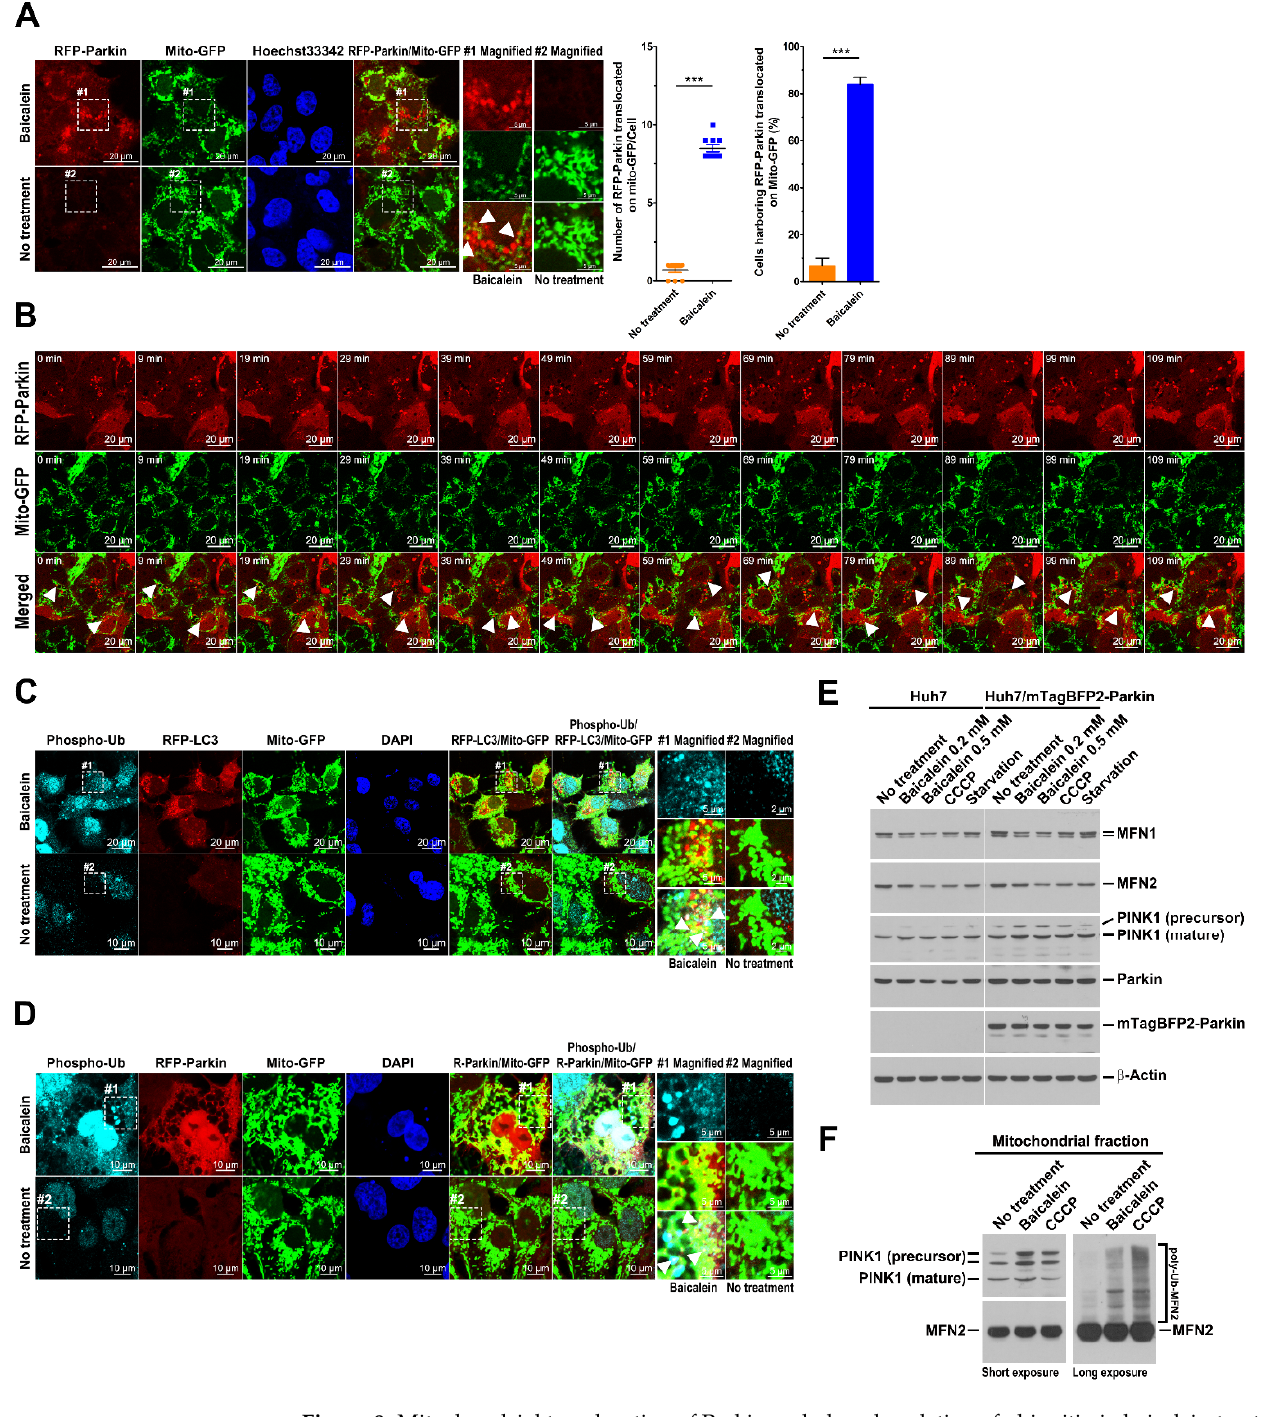
Figure 8. Mitochondrial translocation of Parkin and phosphorylation of ubiquitin in baicalein-treated cells: ( A ) Huh7 cells coexpressing RFP-Parkin and Mito-GFP (Huh7/RFP-Parkin/Mito-GFP) were established by lentiviral gene delivery as described in “Materials and Methods”. The cells were treated with or without 0.5 mM baicalein for four hours, fixed, stained with Hoechst 33342, and analyzed by microscopy. The number of RFP-Parkin translocated into the Mito-GFP was quantified. The data represent the means ± SEM ( n = 10, *** p < 0.001). The percentage of cells containing RFP-Parkin translocated into the Mito-GFP was quantified, and the data represent the means ± SEM of three independent experiments (*** p < 0.001). Magnified field-1 and magnified field-2 show enlarged images of the areas in white dashed boxes 1 and 2 in the images of baicalein-treated and untreated cells, respectively. The white arrowheads in magnified field-1 indicate the overlapping